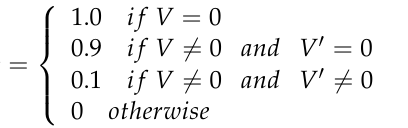
Table 1. The reconfigurability description of HPDME-ASVIS. Reconfiguration Reconfiguration Condition Constraints State Method Goal controllable under hard hard constraints - full goal F constraints uncontrollable under hard software constraints controllable soft constraints full goal I adjustment under soft constraints uncontrollable under hard constraints hardware - safety goal II uncontrollable under soft adjustment constraints other cases - - unreconfigurable